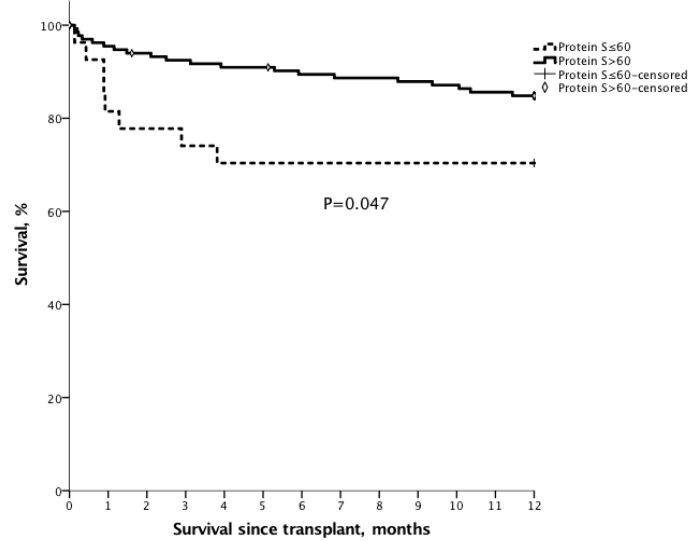
Figure 2. The Kaplan–Meier survival curve of patients waiting for liver transplantation with protein S ≤ 60%. For all enlisted patients, the 6 month and 1 year overall survival for the patients with protein S ≤ 60% ( n = 48) were 74.3% and 69.9%, compared with 88.1% ( p = 0.008) and 84.1% ( p = 0.012) for the patients with protein S > 60%, respectively.